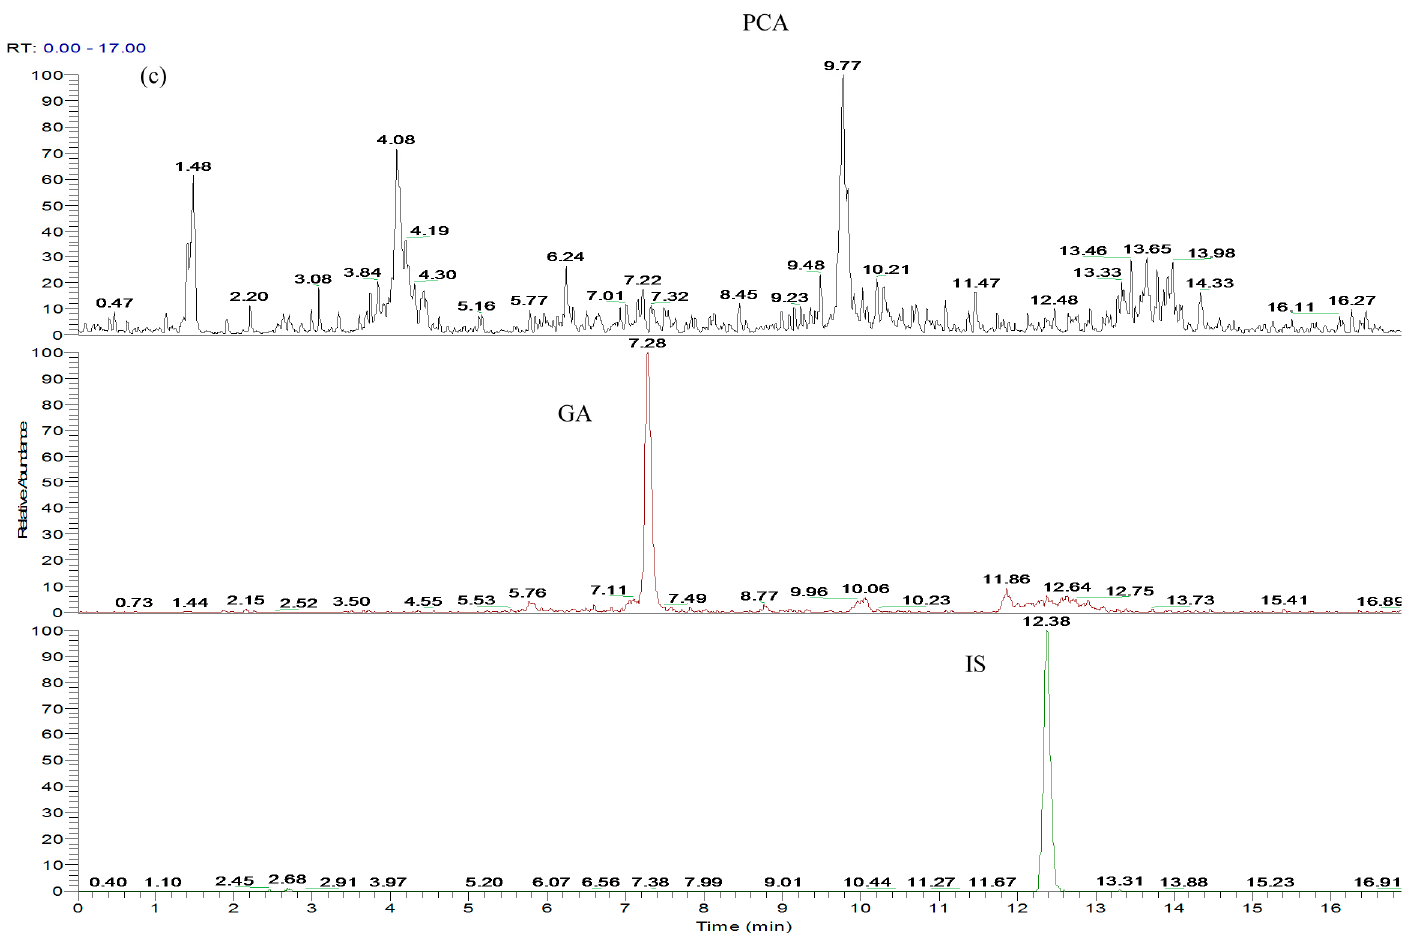
Figure 1. Representative MRM chromatograms of GA, PCA and IS (bergenin) in rat kidney: ( a ) blank kidney homogenate; ( b ) blank kidney homogenate spiked with GA, PCA and IS at LLOQ concentration of 30.00, 9.95 and 10.01 ng/mL, respectively; ( c ) kidney homogenate at 60 min after oral administration of 60 mg/kg P. capitatum extract (184.68 ng/mL for GA and 11.82 ng/mL for PCA).